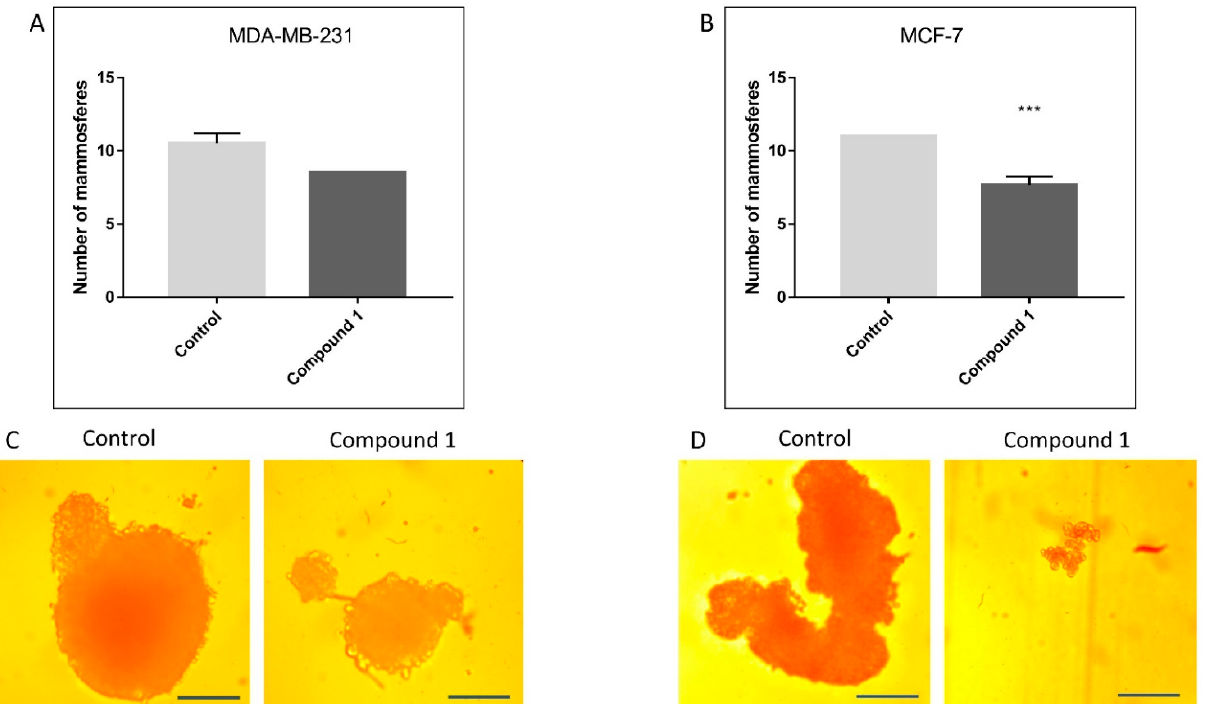
Figure 3. Mammosphere formation after compound 1 treatment. Notes: Number of mammospheres without and with compound 1 treatment for 7 days in the MDA-MB-231 ( A ) and in the MCF-7 cell line ( B ), and photos with × 100 magnification (scale bar, 200 µ m) in the MDA-MB-231 ( C ) and in the MCF-7 cell line ( D ). Mammospheres with a size over 50 µ m were evaluated. Data represented are expressed as a mean from experiment performed in triplicate ± SD. Columns, mean of cells; bars, SD; *** p < 0.001. SD, standard deviation.